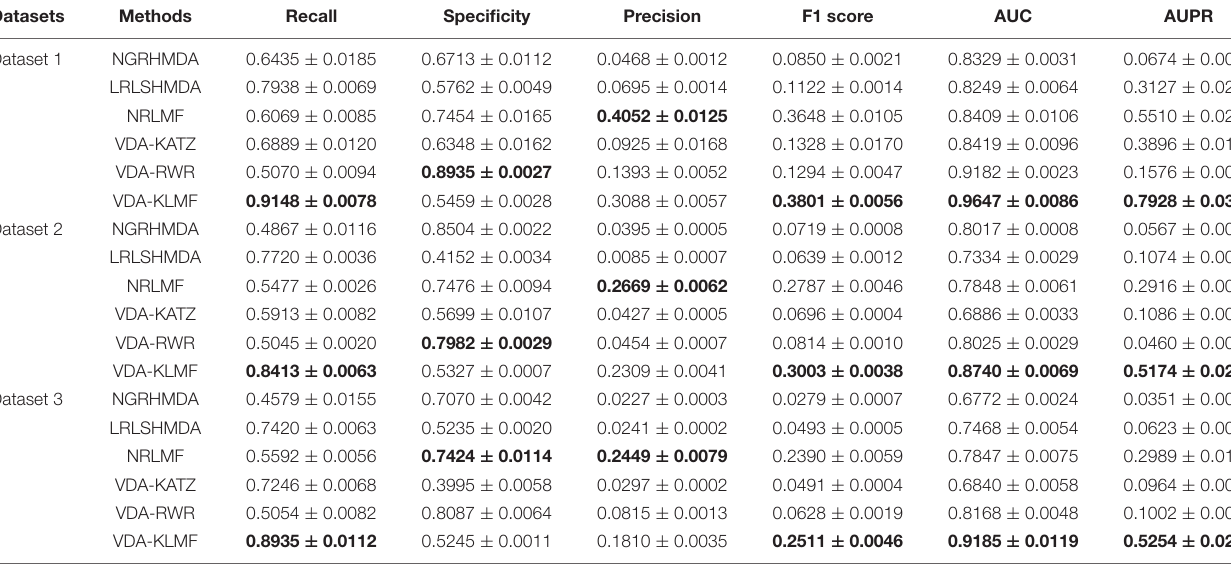
TABLE 4 | The performance of six VDA prediction methods on three datasets under CV2.